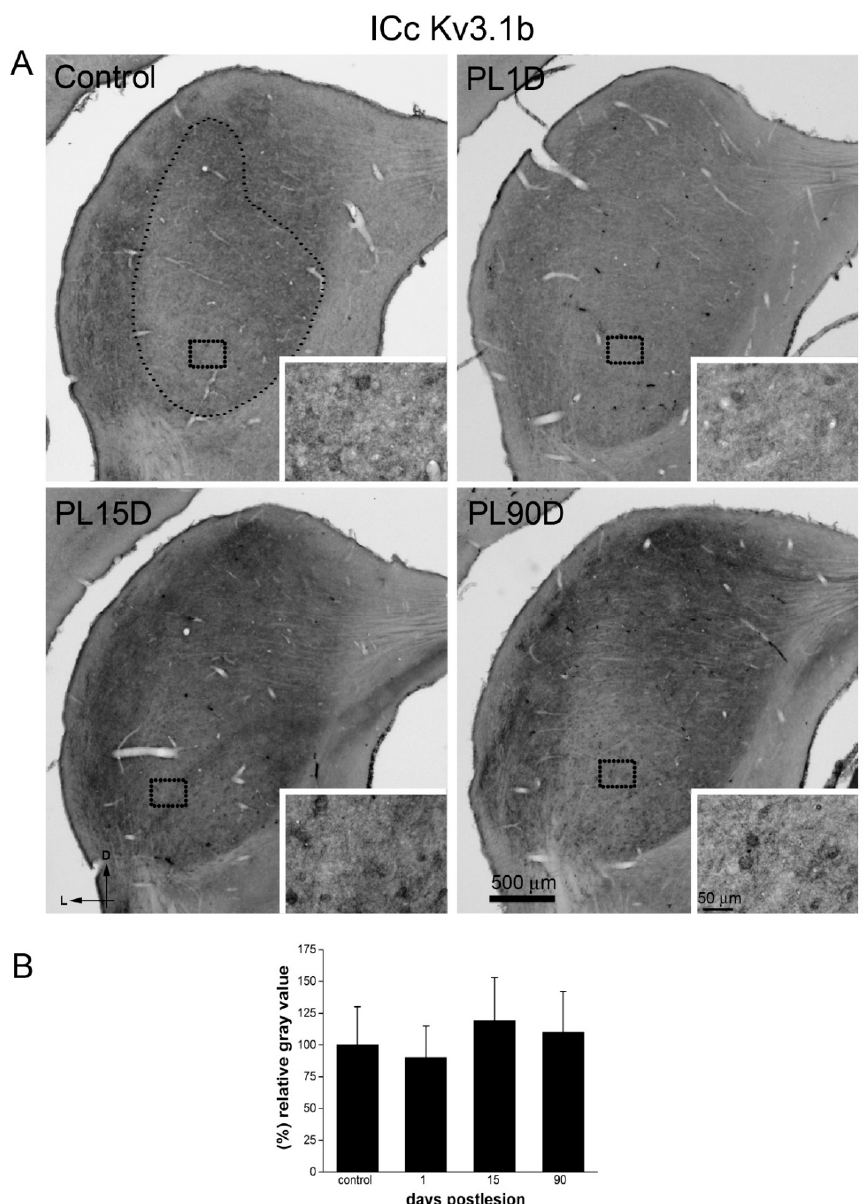
Figure 8. Kv3.1b immunoreactivity levels do not change significantly in the ICc after cochlear lesion. ( A ) Low-magnification photomicrographs of coronal sections of IC. The dotted contour in A (small dots), shows an example of the region of interest, the ICc, where thresholding segmentation was carried out for quantitative immunocytochemistry. Equivalent regions where selected in all sampled sections of the IC. Insets (outlined with large dots in A and B) show high-magnification details. Photographs are representative of five animals. Calibration bars apply to all panels in the figure. ( B ) Quantitative analysis of relative gray values averages at each post-lesion time for Kv3.1b in the ICc. Data are expressed as mean ± S.D. Di ff erences are not statistically significant as determined by one-way ANOVA (F (3,37) = 2.218; p = 0.102), Sche ff e and Tukey post- hoc tests.